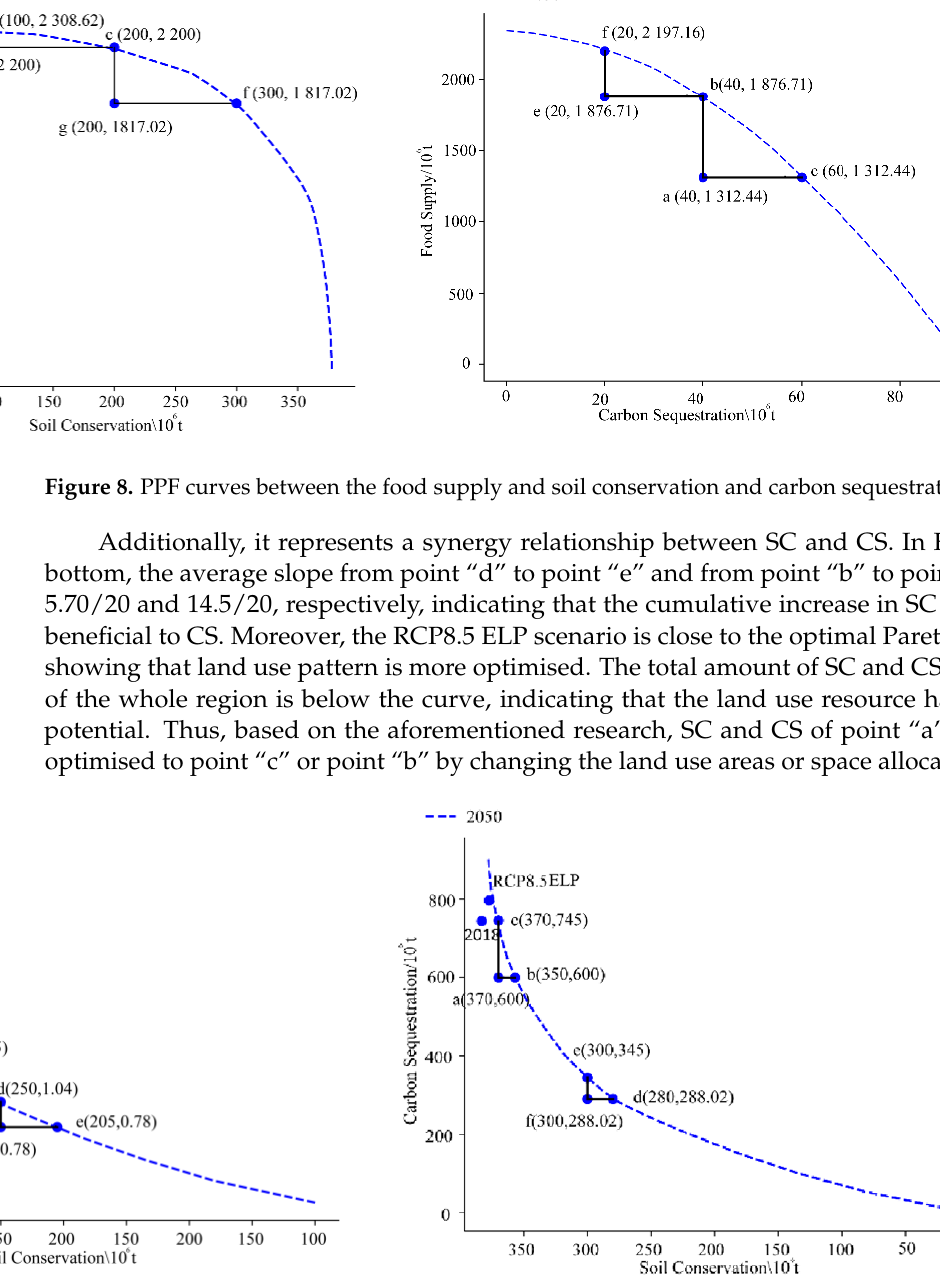
Figure 8. PPF curves between the food supply and soil conservation and carbon sequestration.